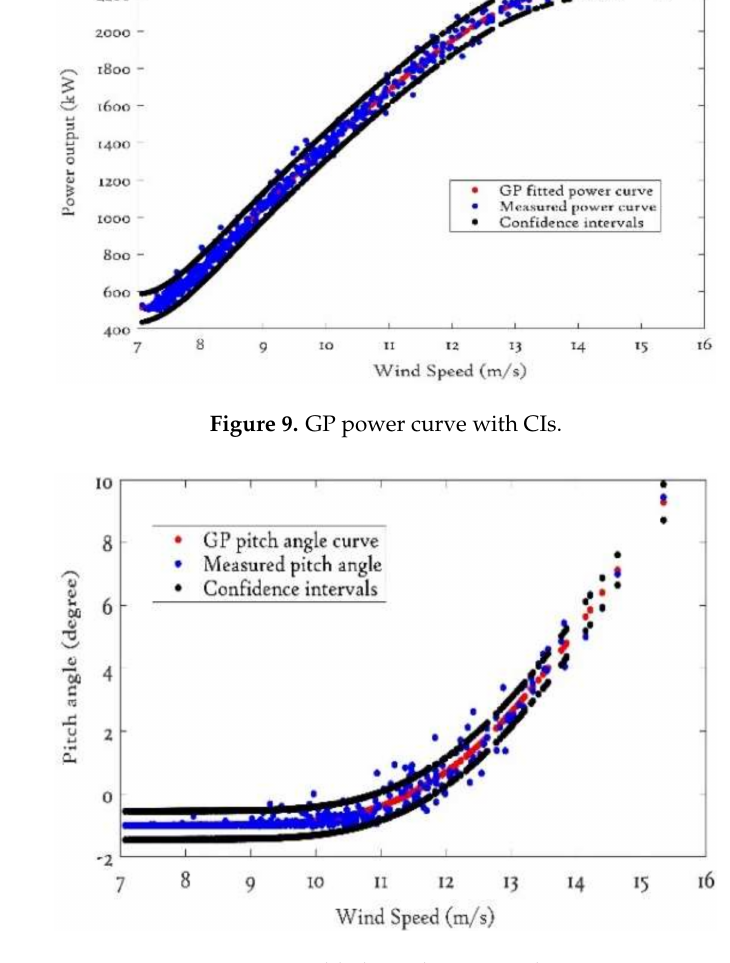
Figure 10. GP blade pitch curve with